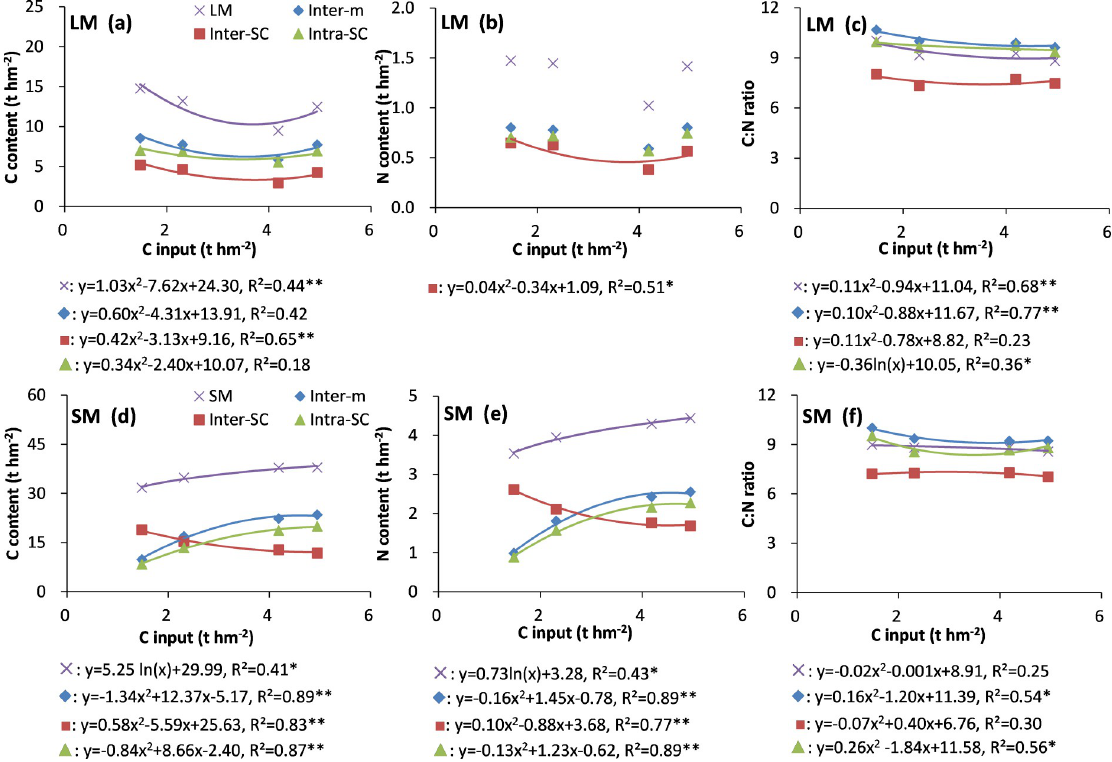
Fig 7. Relationships between C inputs and C and N stocks and their C/N ratios in POM, selected large and small macroaggregate fractions in the top 40 cm of the soil profile of the different treatments. Values are the mean of three replicates. C input sequence on the x-axis is CK, NPK, MNPK, and 1.5MNPK treatments, respectively; � and �� , P < 0 . 05 and P < 0 . 01 ; R 2 is calculated using all replicates of the treatments. Symbols of aggregate fractions: see Fig 1